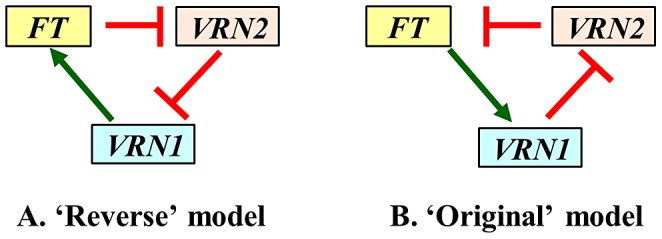
Alternative flowering models in the temperate grasses.A) ‘Reverse model’ [13], B) ‘Original model’ [12], [37].Green arrows indicate promotion of transcription and red lines repression of transcription.